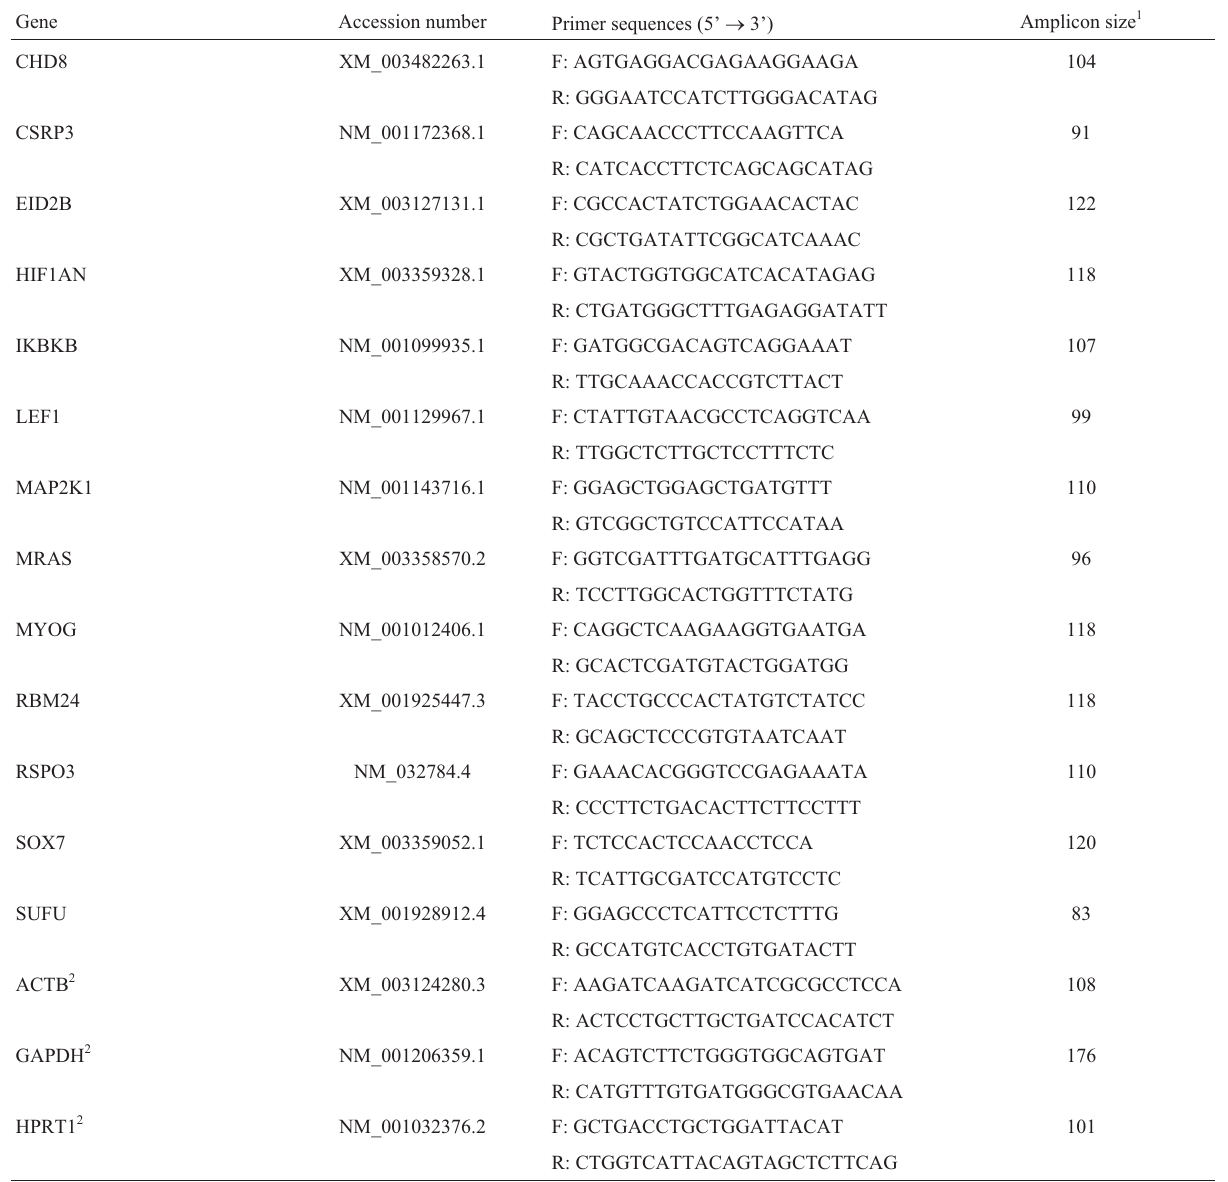
Table 1 - GenBank accession numbers, primer sequences and amplicon sizes of the genes analyzed in this study. Gene Accession number Primer sequences (5’ (cid:2)